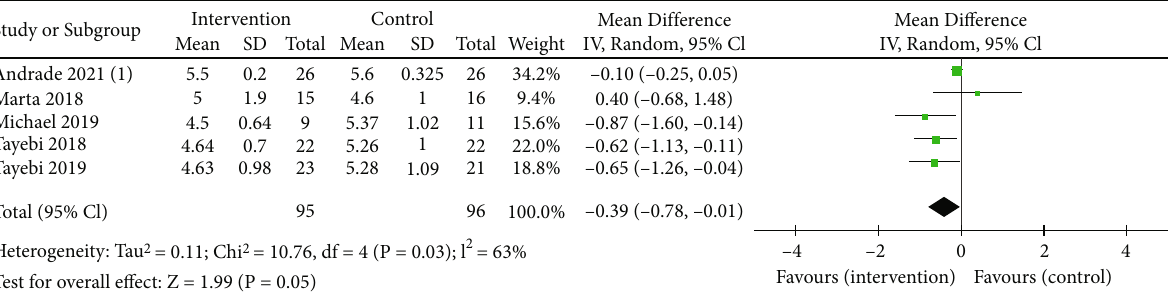
Figure 6: Pooled estimated e ff ect of RS intake on blood phosphorus (mg/dl) in patients with CKD, with estimated MD and 95% CIs. Table 2: Summary of the e ff ects of RS intake in patients with CKD compared with control. No. Outcome